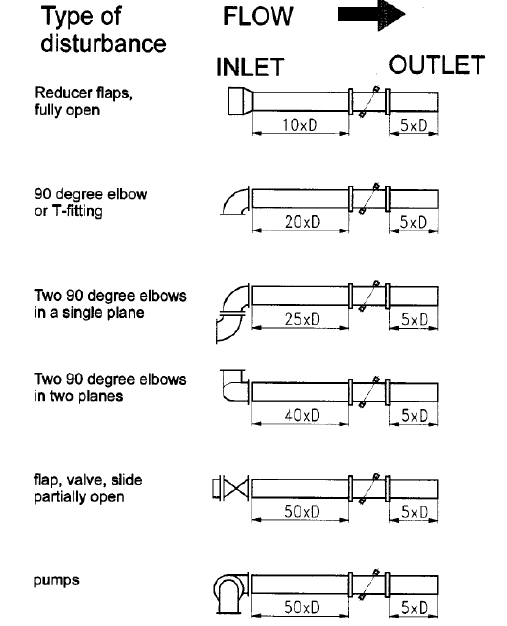
Fig. 2 Minimum straight pipe length for 1% accuracy of a single path transit time flowmeter